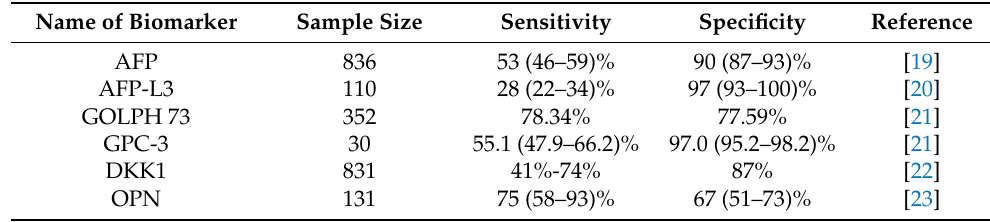
Table 1. Disease marker and number of samples in